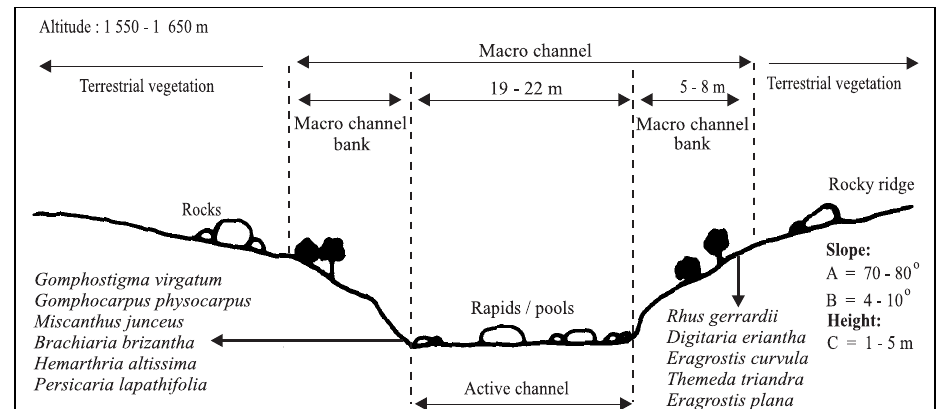
Fig. 7. River profile of the Rhus gerrardii-Hemarthria altissima grassland.